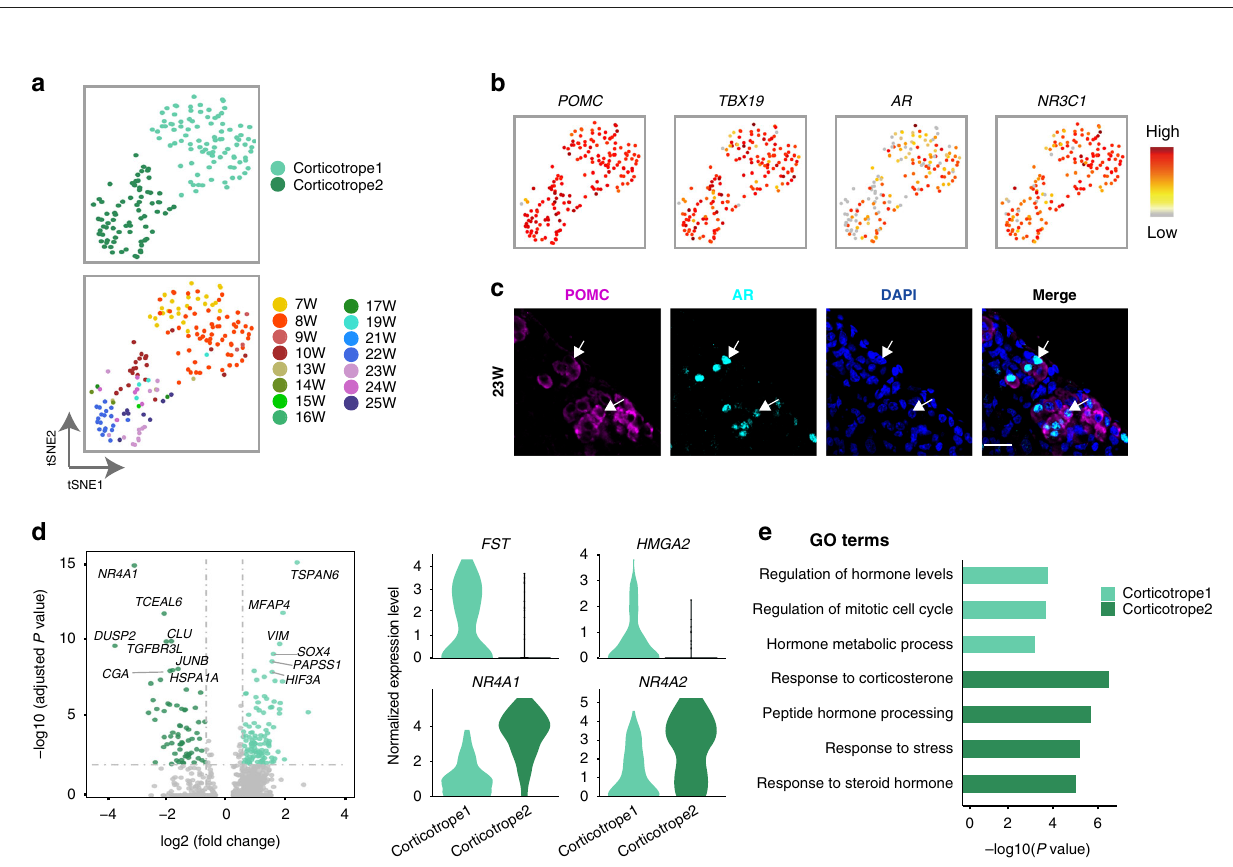
Fig. 4 Pseudotime developmental trajectories of hormone-producing cells. a Pseudotime analyses of the endocrine cells shown in the UMAP plot. Left: the RNA velocity result with the arrows predicting directions of the pseudotime. Right: the Slingshot result with the lines indicating the trajectories of lineages and the arrows indicating manually added directions of the pseudotime. Dots: single cells; colors: cell types. Yellow circle in the right panel represents the start point of the trajectories which was set as the Stem1 subcluster. Since the corticotrope was already a separate cluster in the earliest sample (7 weeks), the corticotrope trajectory may start from stem cells earlier than Stem1. The CC cluster was omitted in the Slingshot pseudotime analysis as it contained several cell types and caused wrong trajectories. b Heatmap showing the relative expression of TFs displaying signi fi cant changes ( P ≤ 1E − 5) along the pseudotime axis of each lineage. The progenitor or precursor cells of each lineage were enclosed in frames of dashed lines. Colors: loess-smoothed expression (red, high; blue, low). The columns represent the cells being ordered along the pseudotime axis with the cell type and fetal week informations being shown above. Rows represent genes being ordered by their peak expression along the pseudotime axis. P values are determined by one way ANOVA test. c Scatterplots showing the expression levels of representative TFs along the pseudotime axis. Dots: single cells; colors: cell types. d Venn diagram of downregulated and upregulated TFs along the pseudotime axis of each lineage. Representative TFs were listed in the right boxes.